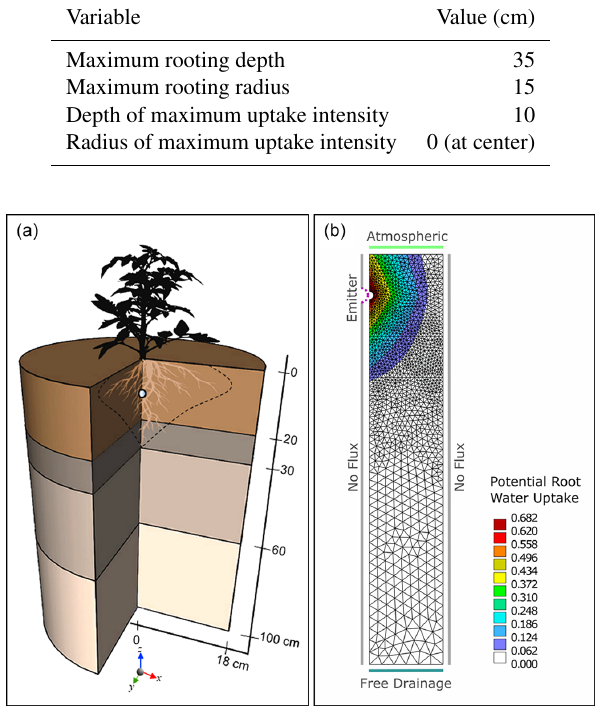
Figure 2. (a) A 3D schematic representation of the domain geome- try and material distribution. (b) The domain setup in HYDRUS-2D showing the finite element mesh, related boundary conditions, and potential root water uptake rate